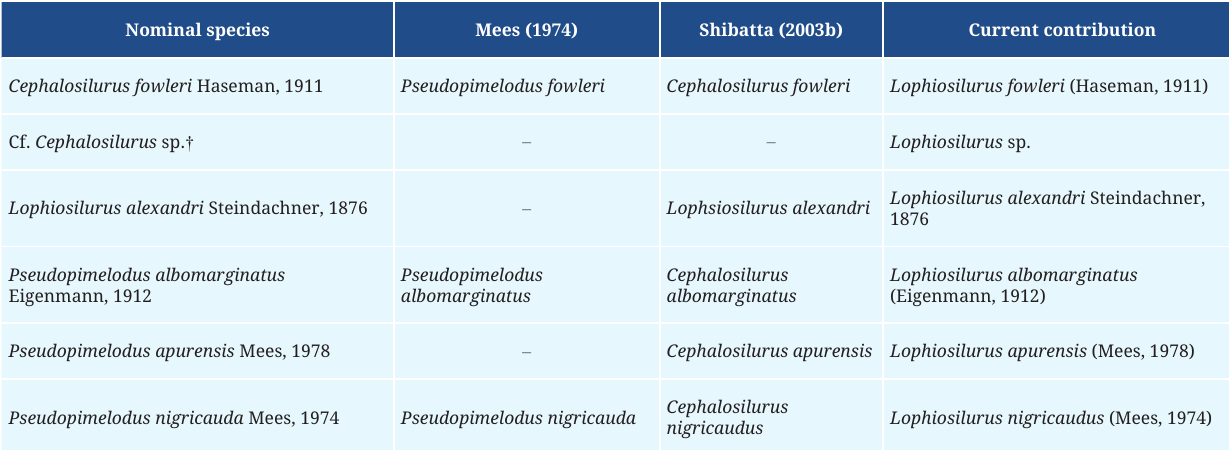
TABLE 1 | Key taxonomic publications with changes in the names of Lophiosilurus species. † undescribed fossil species identified by Lundberg et al .